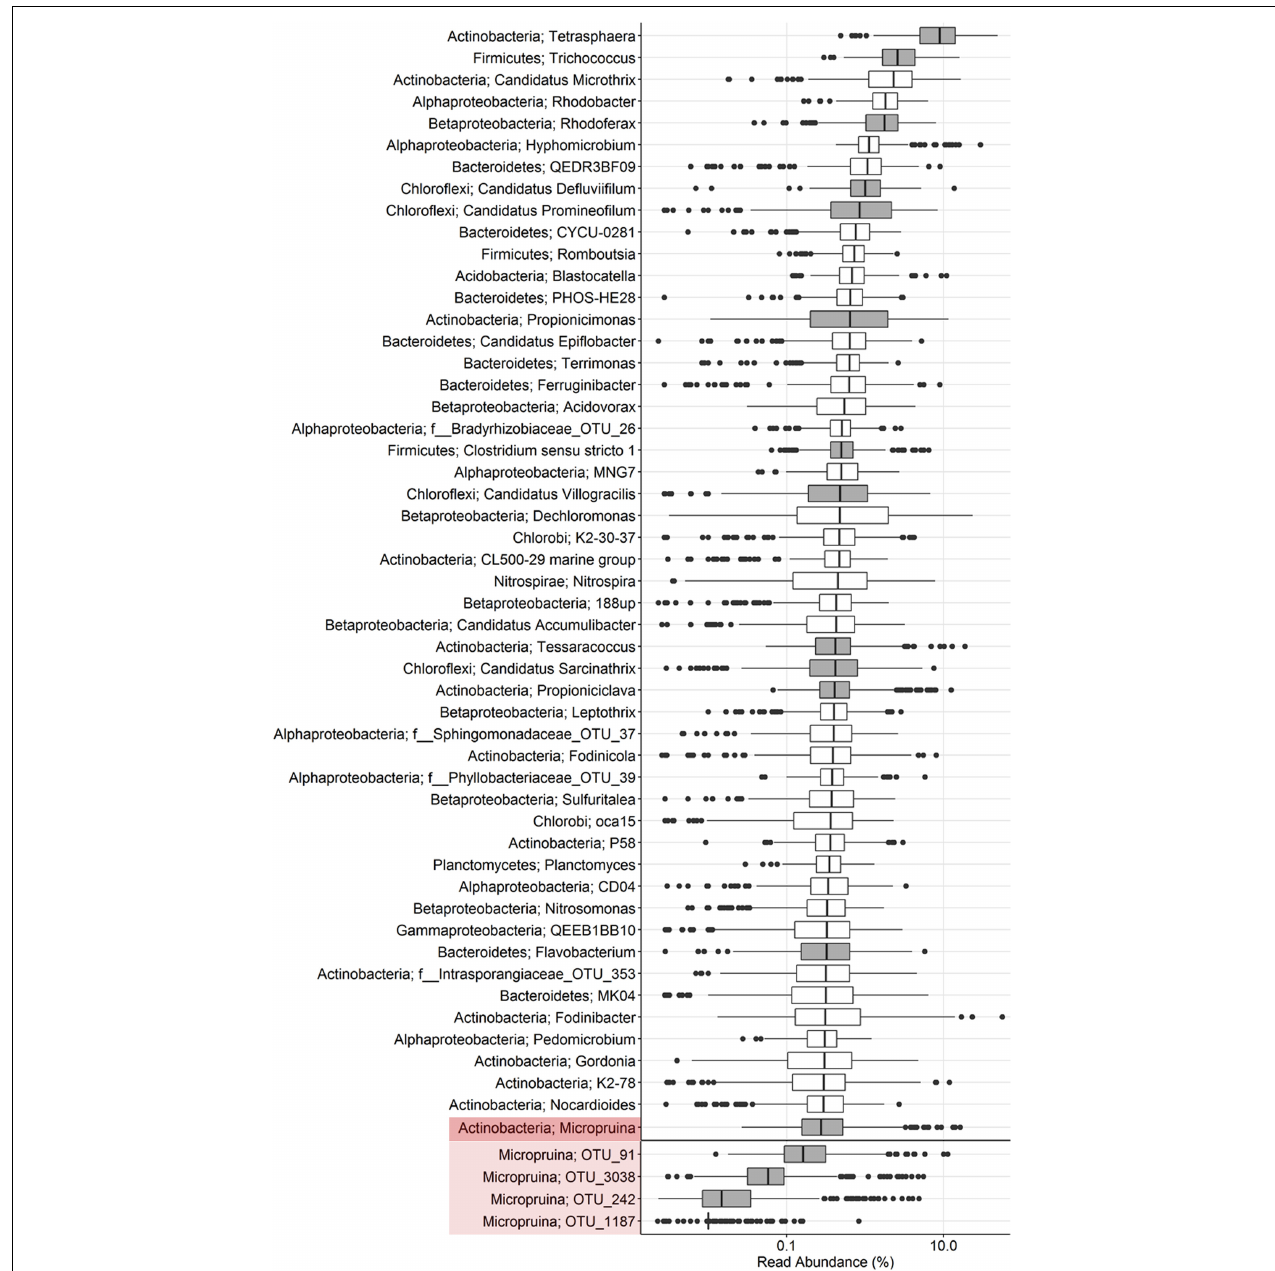
FIGURE 3 | Boxplot showing the abundance distribution of the top genus-level phylotypes as well as individual OTUs belonging to the genus Micropruina in Danish EPBR plants. The data source is an extensive 16S rRNA gene amplicon sequencing (V1–3 region) survey of 18 plants over an 8-year period (2006–2014). For further details, see Stokholm-Bjerregaard et al. (2017). Phylotypes with gray box plots are those known to be associated with a fermentative